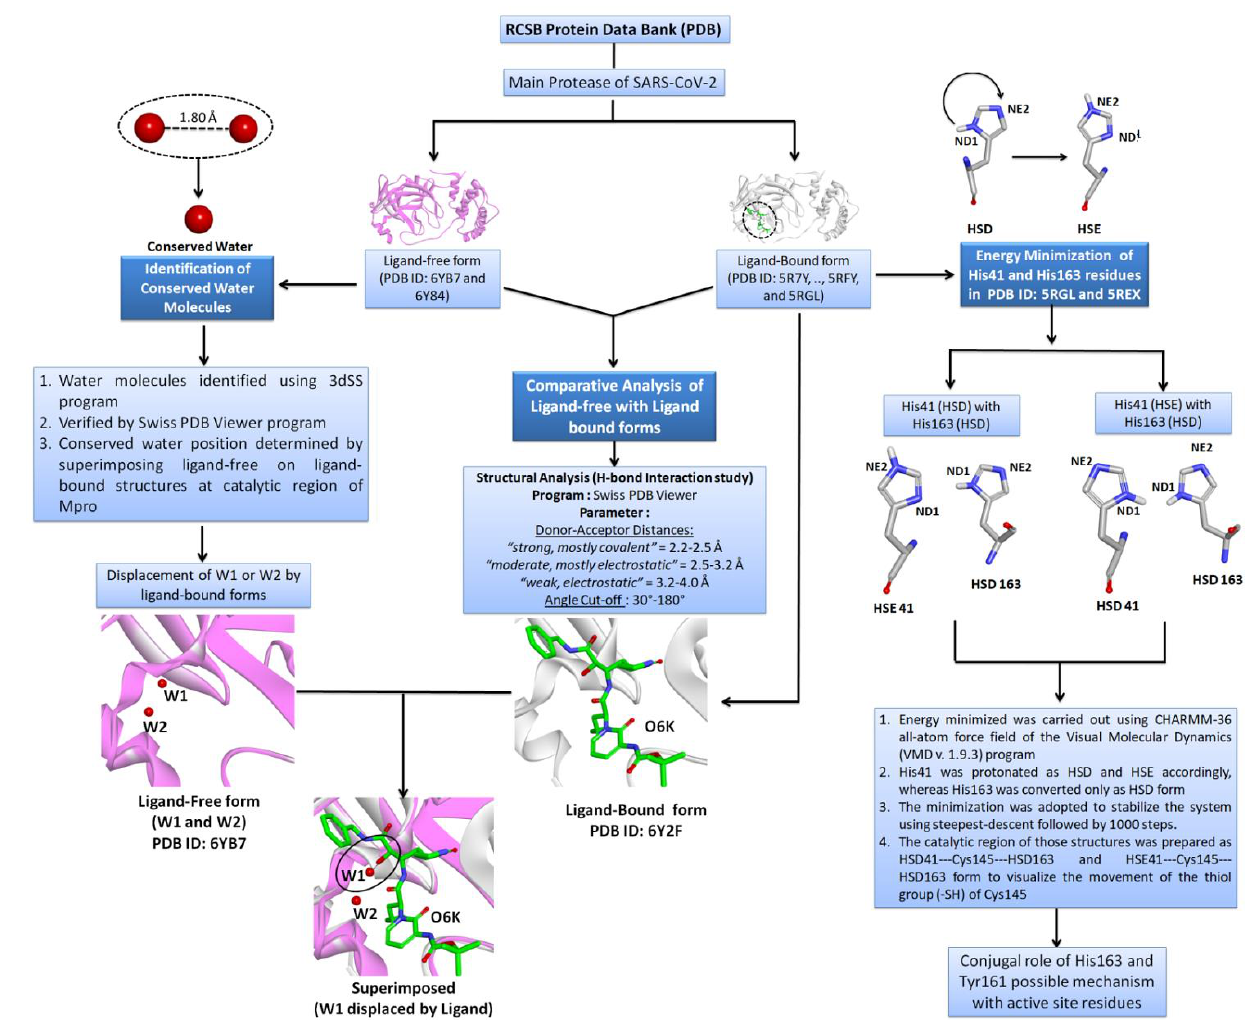
Figure 2. The flowchart of the computational methodology was described accordingly. The protein structure selection, characterization, and comparative analysis were executed to elucidate the possible mechanism of